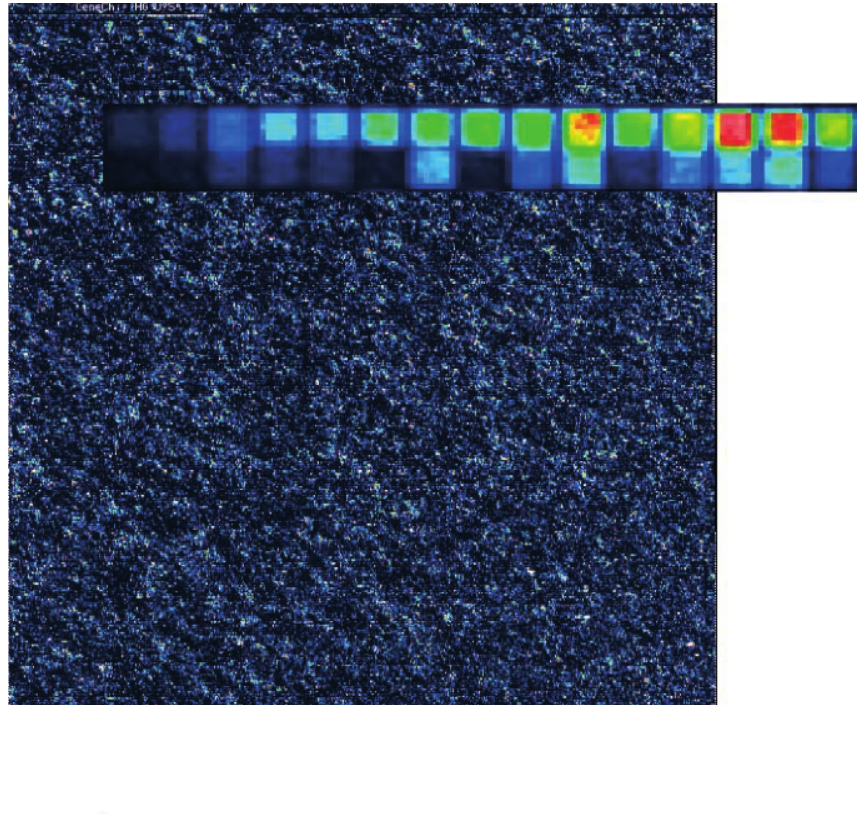
Scatter plot of the mean gene expression in sarcoidosis patients compared to controls. Apoptosis-related genes discussed in this pub- lication are highlighted in colour-codes (for ab- breviations see table 2), which allows estima- tion of the extent of the regulated expression in the context of the overall transcriptional ac- tivity. Gene expression in both phenotypes is very similar for most of the genes tested result- ing in a R-square of 0.98. Also given are cut- offs of 1.3 and 0.7 expression relative to the other phenotype by additional